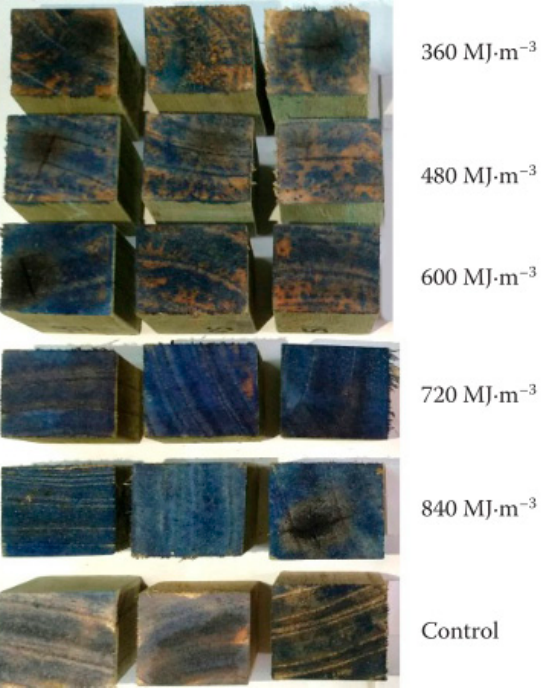
Figure 7. MW-treated samples followed by CCA impregnation according to